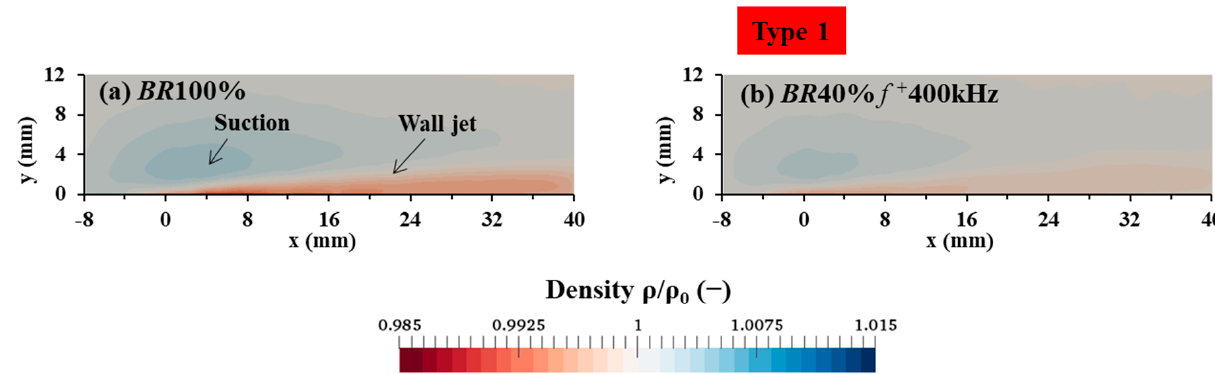
Figure 7. Density-field contours for the case of ( a ) continuous operation with F = 7.2 kHz and BR = 100% and ( b ) burst modulation with F = 7.2 kHz, BR = 40%, and T on = 1 ms ( f + = 400 Hz).